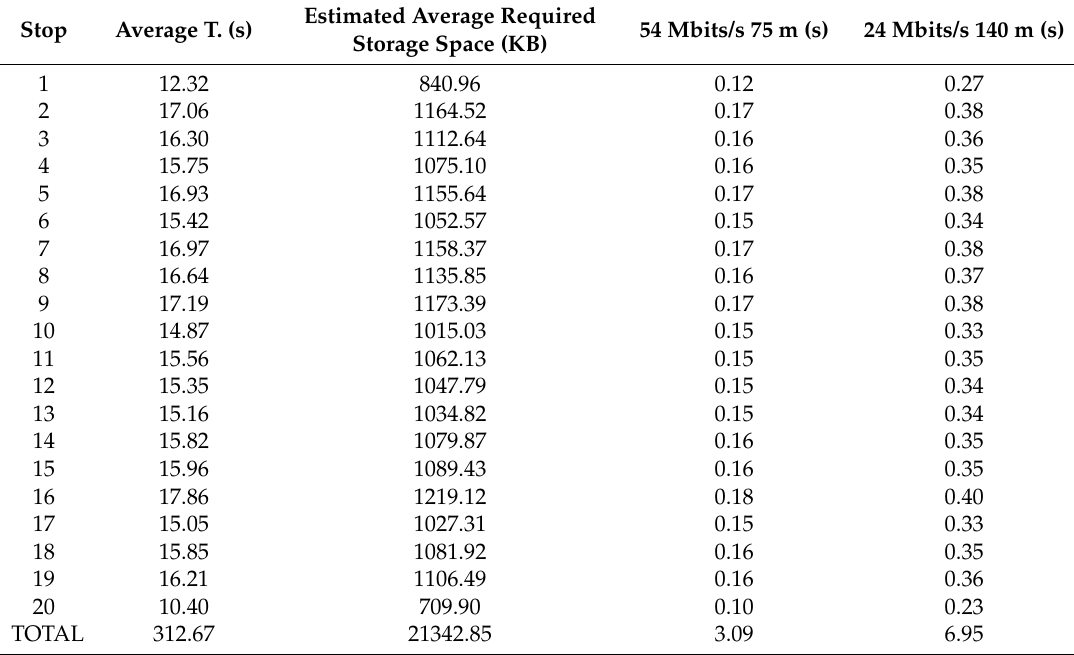
Table 3. Results obtained for representative